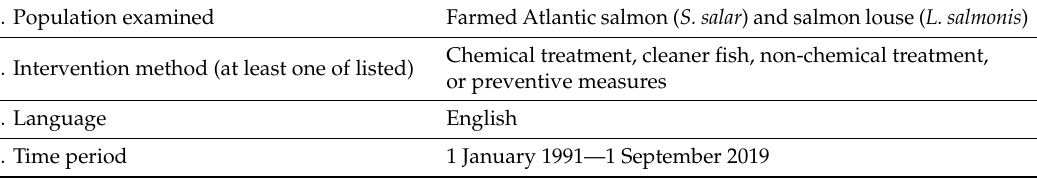
Table 5. Inclusion